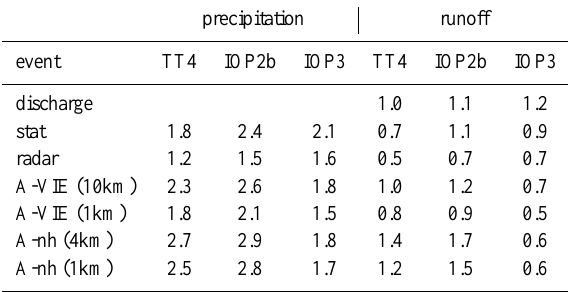
Table 1. Total mean observed or simulated precipitation and